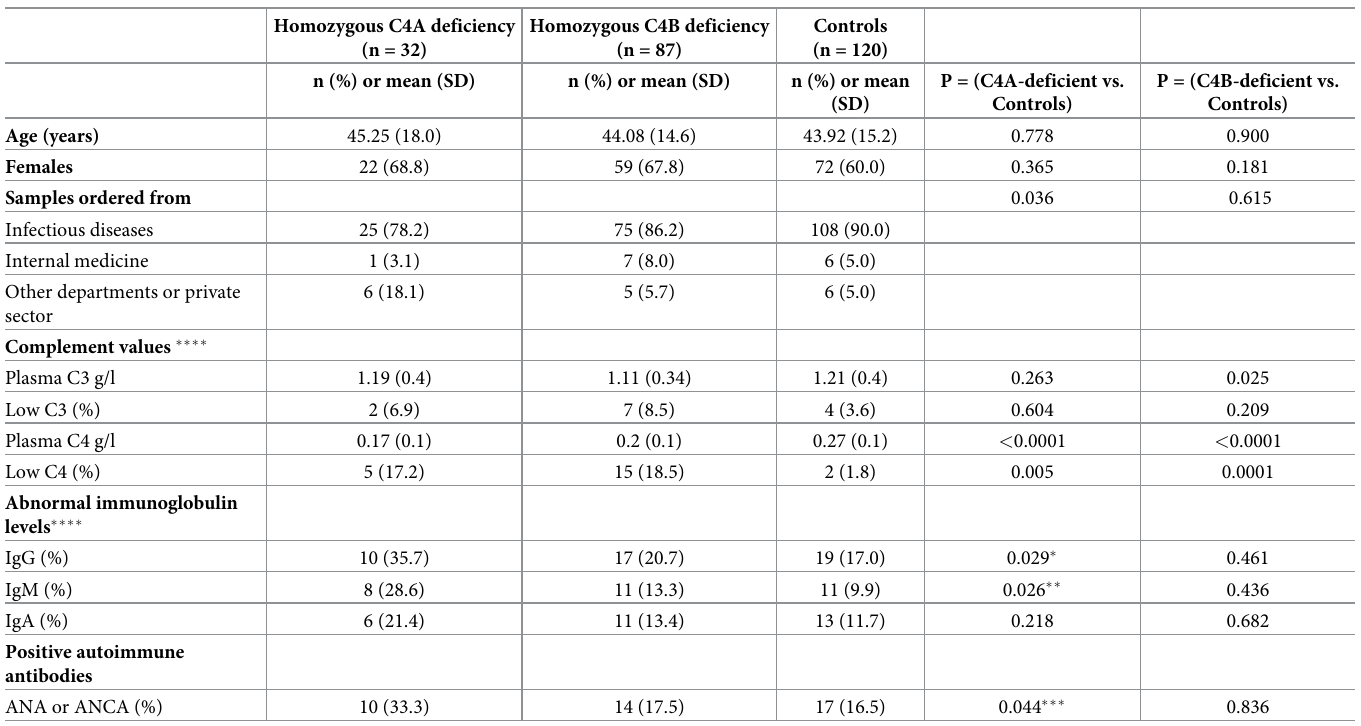
Table 1. Baseline